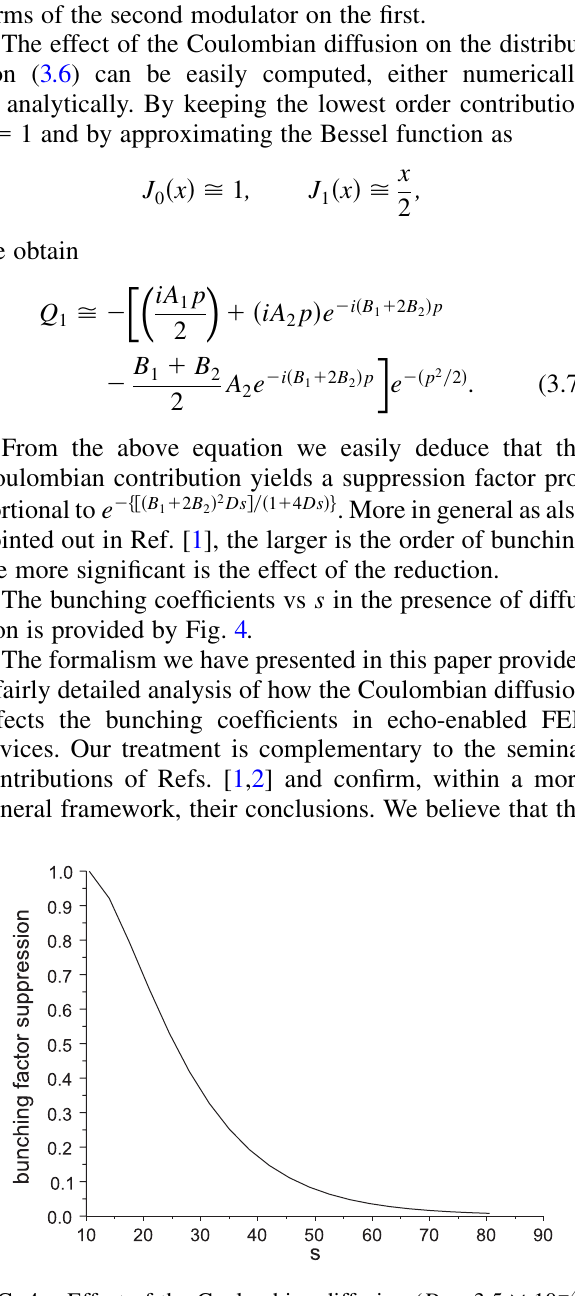
FIG. 4. Effect of the Coulombian diffusion ( D ¼ 3 : 5 (cid:3) 10 (cid:1) 4 ) on the bunching coefficient ( m ¼ 9 ) b 9 ð D Þ =b 9 ð 0 Þ vs s